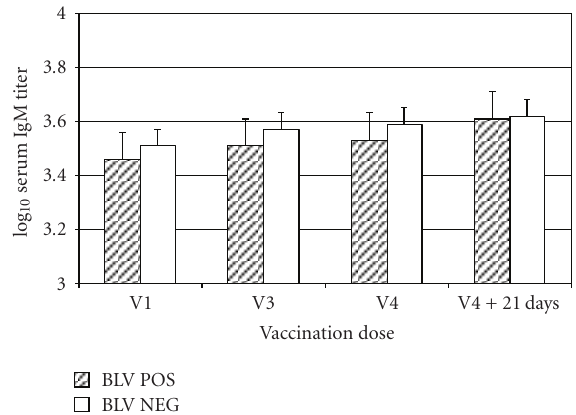
Figure 1: Mean ± SEM serum IgM titers in 22 BLV-positive cows (BLV POS) and 13 BLV-negative cows (BLV NEG) administered a J5 E. coli bacterin with 4 doses of bacterin administered SC in the left side of the neck (odd numbered doses) or right side of the neck (even numbered doses). Blood samples were collected from all cows at the time of the first (V1: approx 7 weeks before parturition), third (V3: second week after parturition (between days 8 and 14 after parturition)), fourth (V4: 5 weeks (between 29 and 35 days) after parturition) vaccinations, and 21 days after the fourth